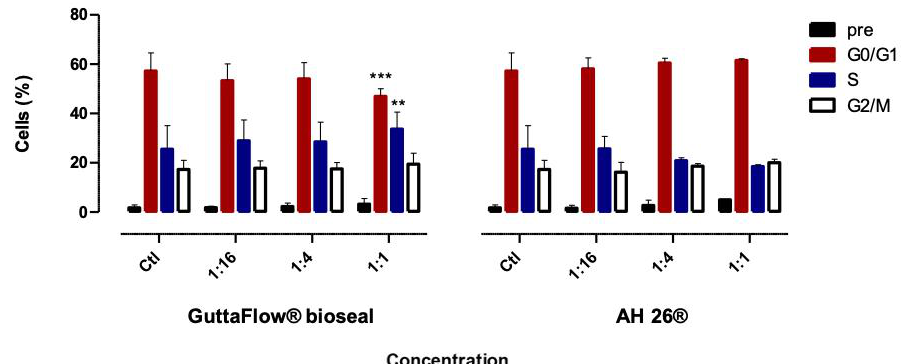
Figure 3. Cell cycle phases of the MDPC-23 cell cultures after 24 h of incubation with the biomaterials conditioned media. The results are presented as the mean and standard error, with a minimum of six independent assays. Statistically significant di ff erences to the control or between conditions are represented by a *, where ** means p < 0.01, and *** means p < 0.001. ® GuttaFlow bioseal at the highest concentration (1:1) determined a decrease of cells in phase G0 / G1, from 57.22 ± 7.29% to 46.88 ± 3.14% ( p < 0.001), which was accompanied by an increase